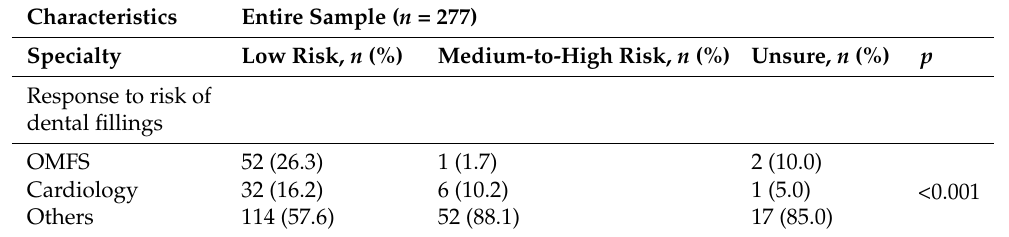
Table 6. Association between the specialists and their response to the questions in Table 5.